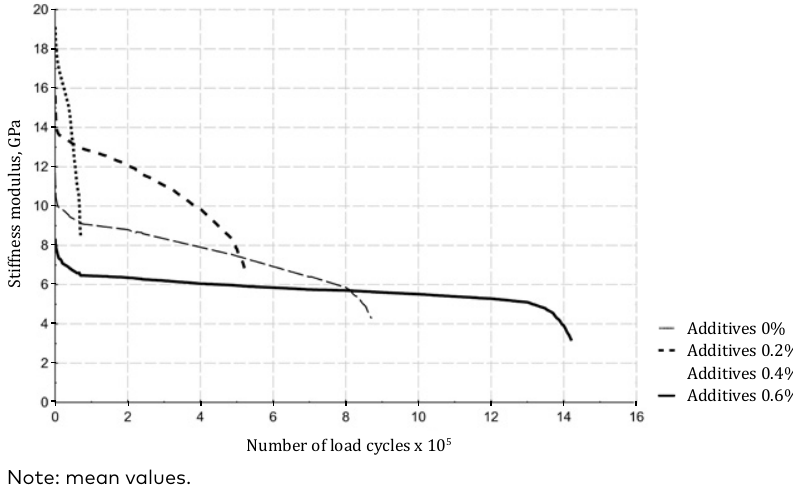
Note: mean values. Number of load cycles x 10 5 Figure 16. The effect of rejuvenator on the fatigue performance